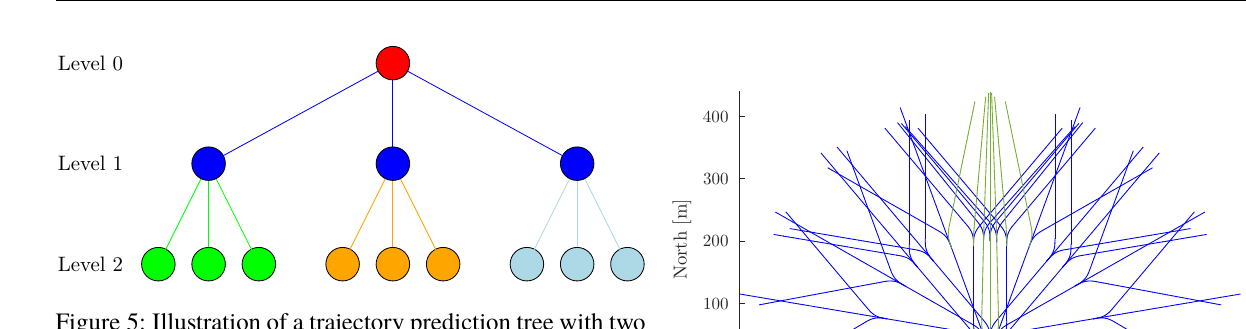
Figure 5: Illustration of a trajectory prediction tree with two levels. The red node is the root node containing the initial vessel configuration. Other colors group nodes and edges associated with each maneuver- generation procedure, which generate three ma- neuvers each time (given by combinations of 𝑁 Figure 6: A set of predicted pose trajectories with three lev- 𝑈 and 𝑁 satisfying 𝑁 3). The tree contains 𝑁 els. Notice how the guidance function shifts some 𝜒 𝑈 · 𝜒 = a total of nine trajectories, each consisting of two of the maneuvers, marked in dark green, to con- sub-trajectories. verge towards the desired trajectory, which is a straight-north trajectory from the initial pose (not shown in the figure). For illustration purposes, the trajectories only contain course maneuvers.